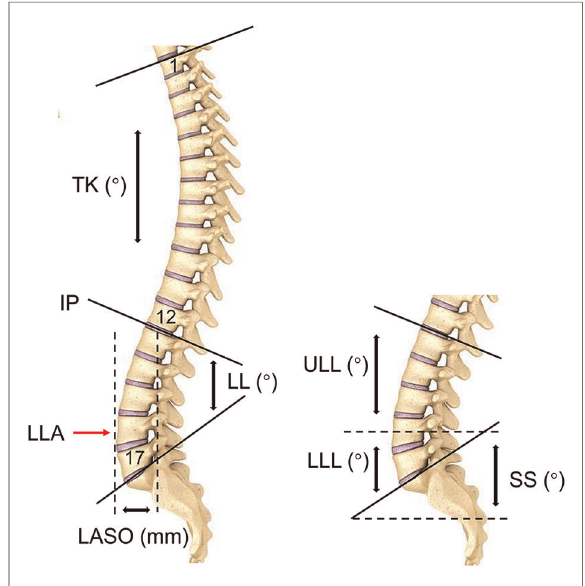
FIGURE 2 The descriptions of sagittal parameters. IP, in fl ection point; LLA, apex of lumbar lordosis; LASO, the horizontal offset between the plumb line of the lumbar apex and that of the posterosuperior corner of S1; ULL, upper lumbar lordosis; LLL, lower upper lumbar lordosis; LL, lumbar lordosis; TK, thoracic